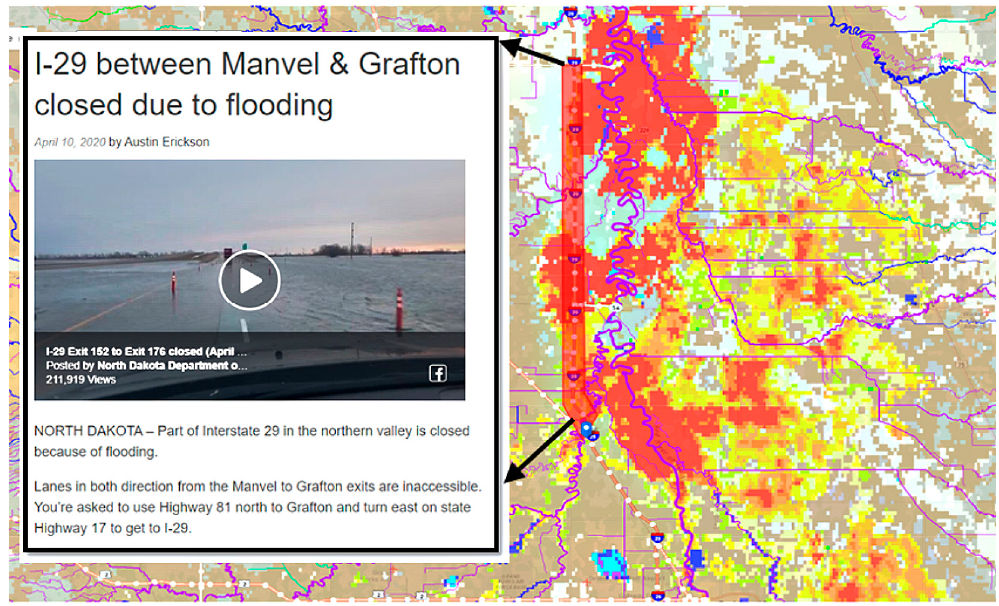
Figure 6. VIIRS 5-day (April 7–11) composite flood product in April 2020 (the color scale is the same as Figures 4 and 5. Courtesy of Dave Jones at the Storm Center).